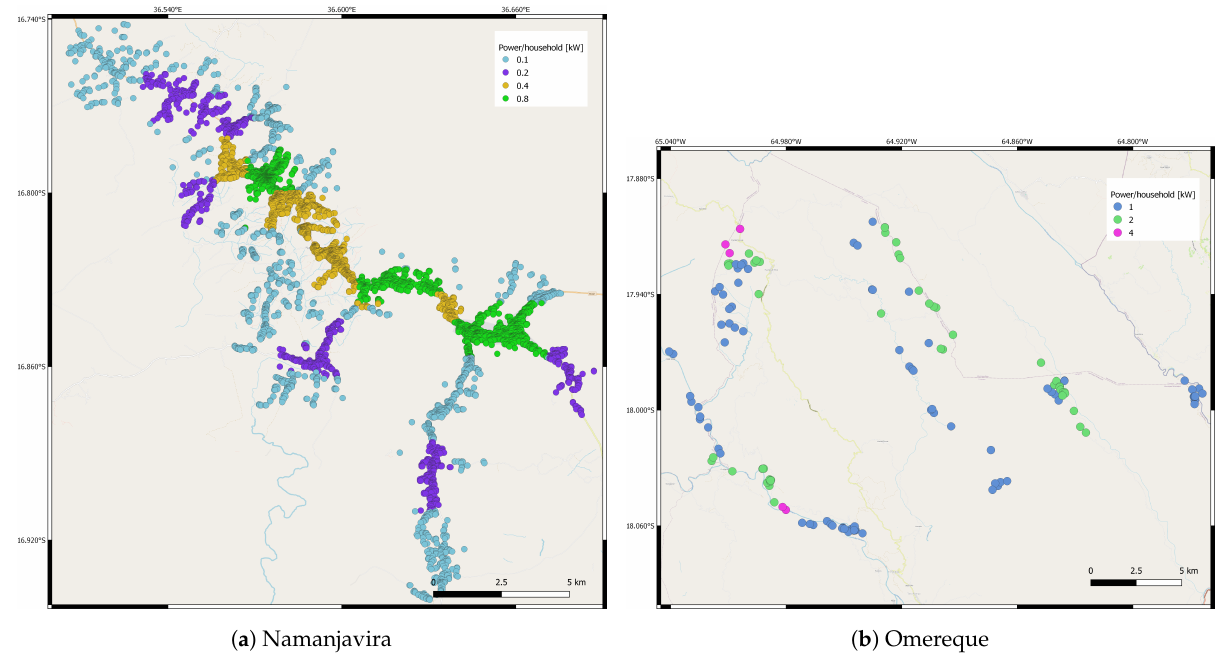
Figure 3. Population distribution of the case studies.